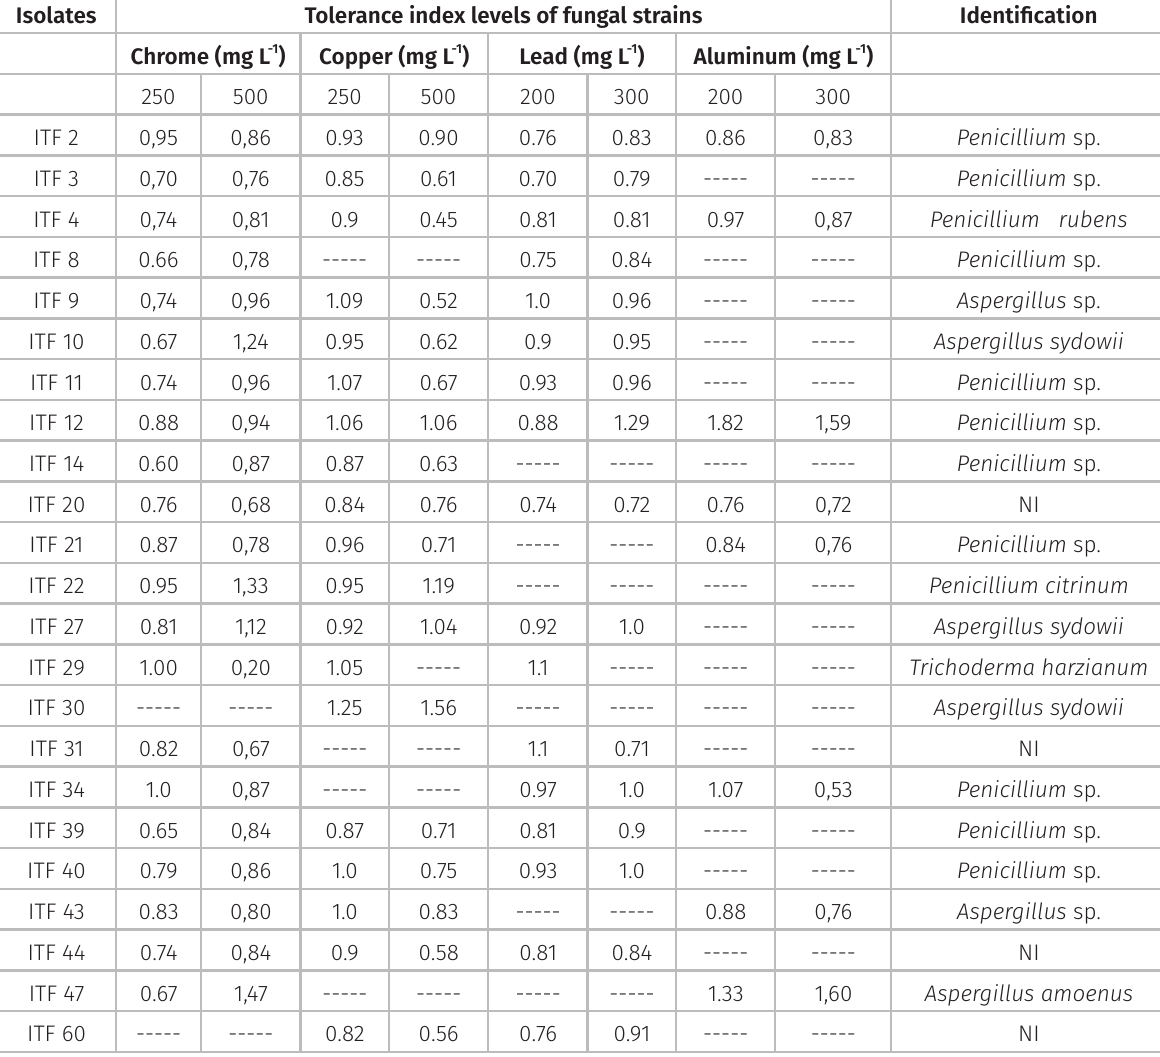
Table I. Tolerance of fungal species to different concentrations of heavy metal. Isolates Tolerance index levels of fungal strains